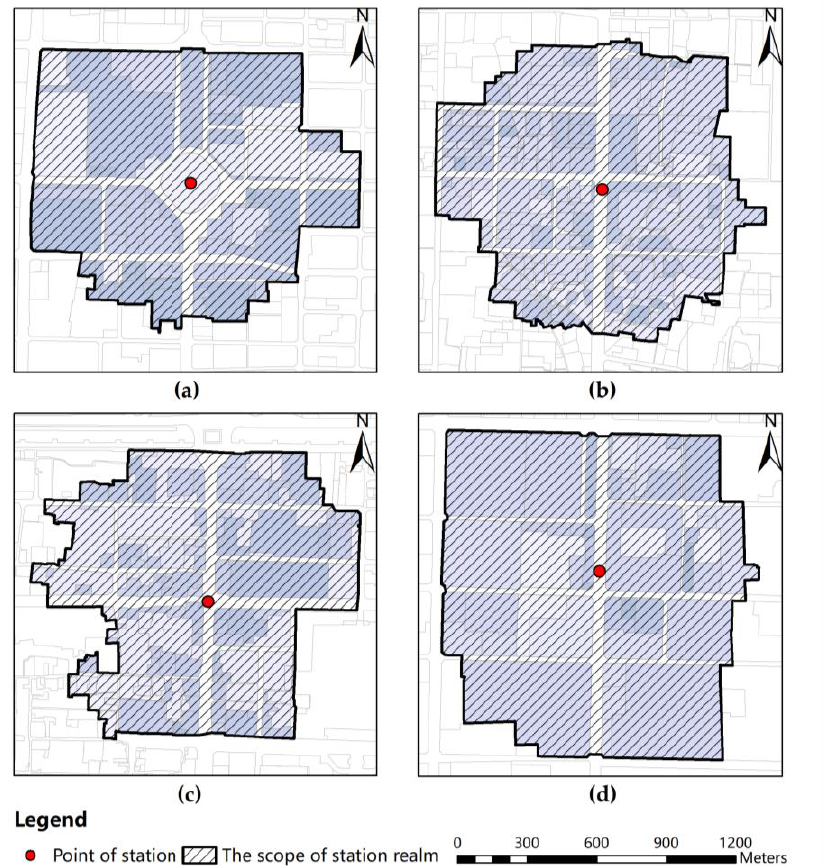
Figure 6. Scope of the four research station realms: ( a ) XZZX Station, ( b ) LSY Station, ( c ) BDJ Station, ( d ) WYJ Station.